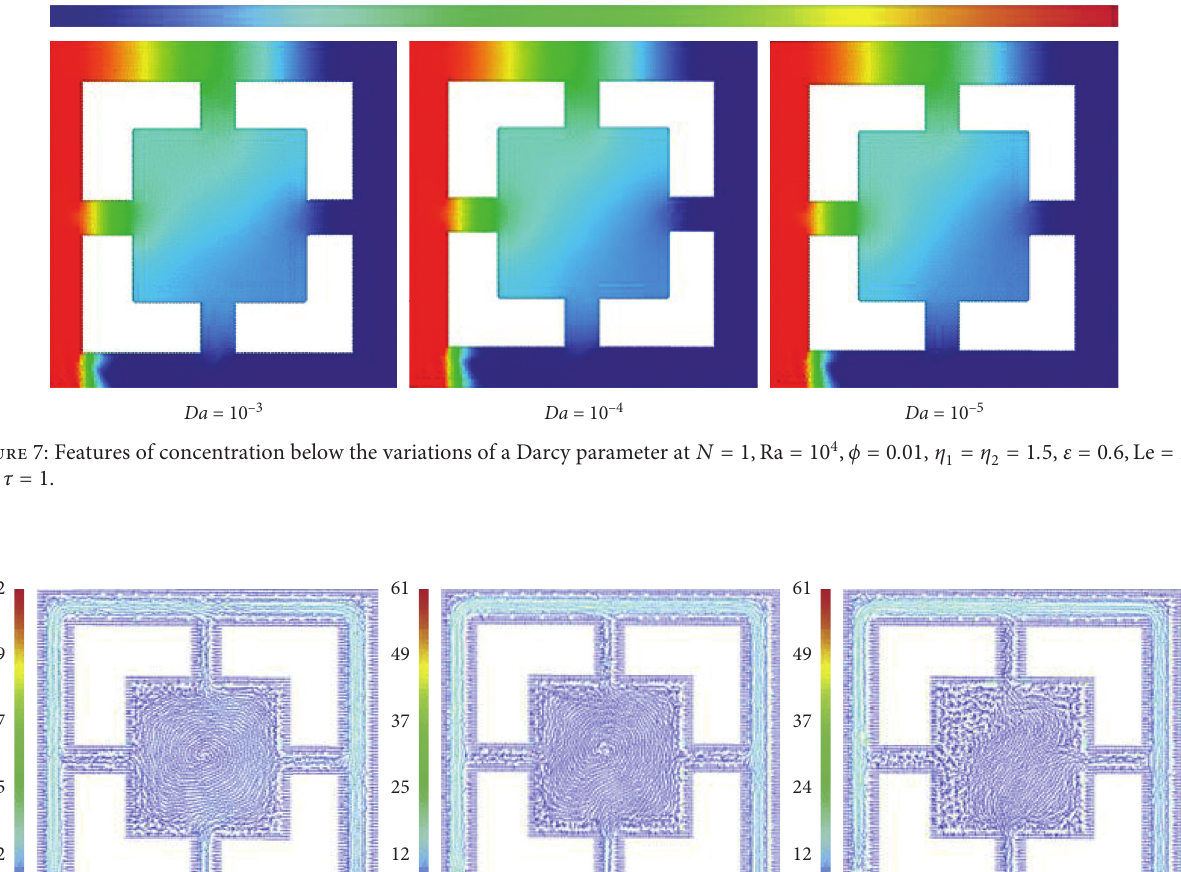
� η � 1 . 5, ε � 0 . 6 , Le � 20, and τ � 1. 1 2